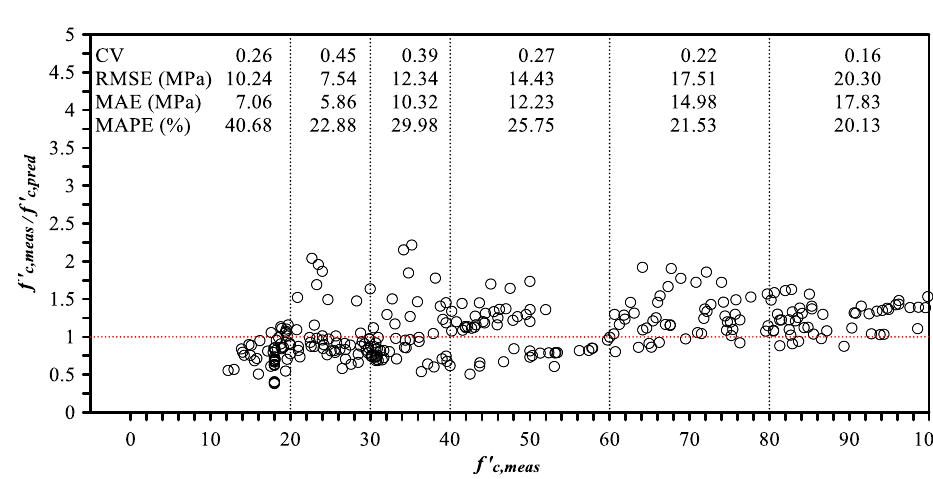
Figure 5. Relationship between γ obtained from Case-2 and f (cid:48) c